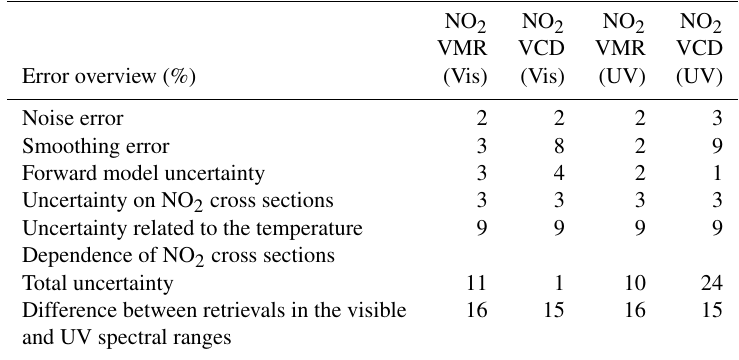
Table 4. Error budget overview of the MMF-retrieved NO 2 VMR and VCD in the visible and UV spectral ranges. The total uncertainty is calculated as the square root of the sum of the squares of the different error